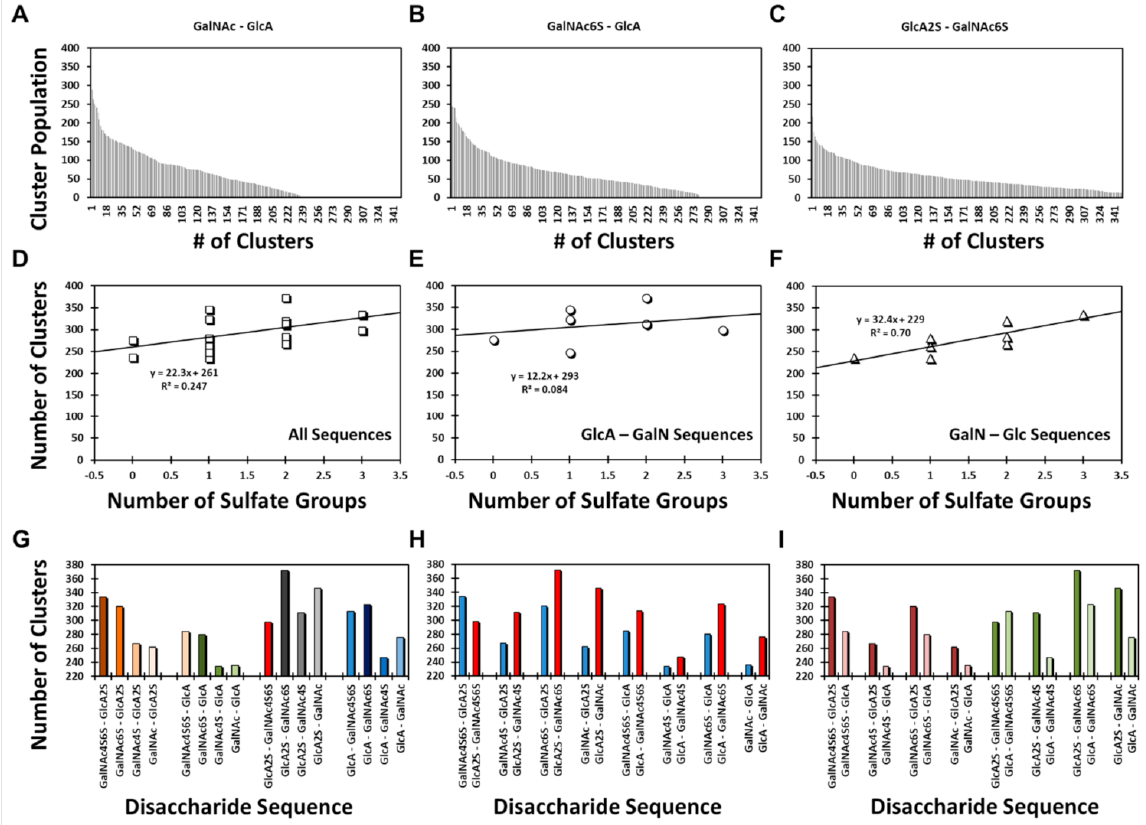
Figure 2. Distinct cluster-based analysis of conformational diversity. Plots of population of clusters as a function of distinct clusters observed in MD simulations of GalNAc–GlcA ( A ), GalNAc6S– GlcA ( B ), and GlcA2S–GalNAc6S ( C ) (see Figure S5 for plots of all 16 disaccharides). Hierarchical agglomerative clustering with the epsilon of 2 was implemented in cpptraj to derive information on distinct clusters observed in MD. Profiles of numbers of distinct clusters observed in MD simulations as a function of the number of sulfate groups on ( D ) all disaccharides, ( E ) 1 → 3-disaccharides, and ( F ) 1 → 4-disaccharides. ( G – I ) Profiles of the variation in the number of distinct clusters as a function of different